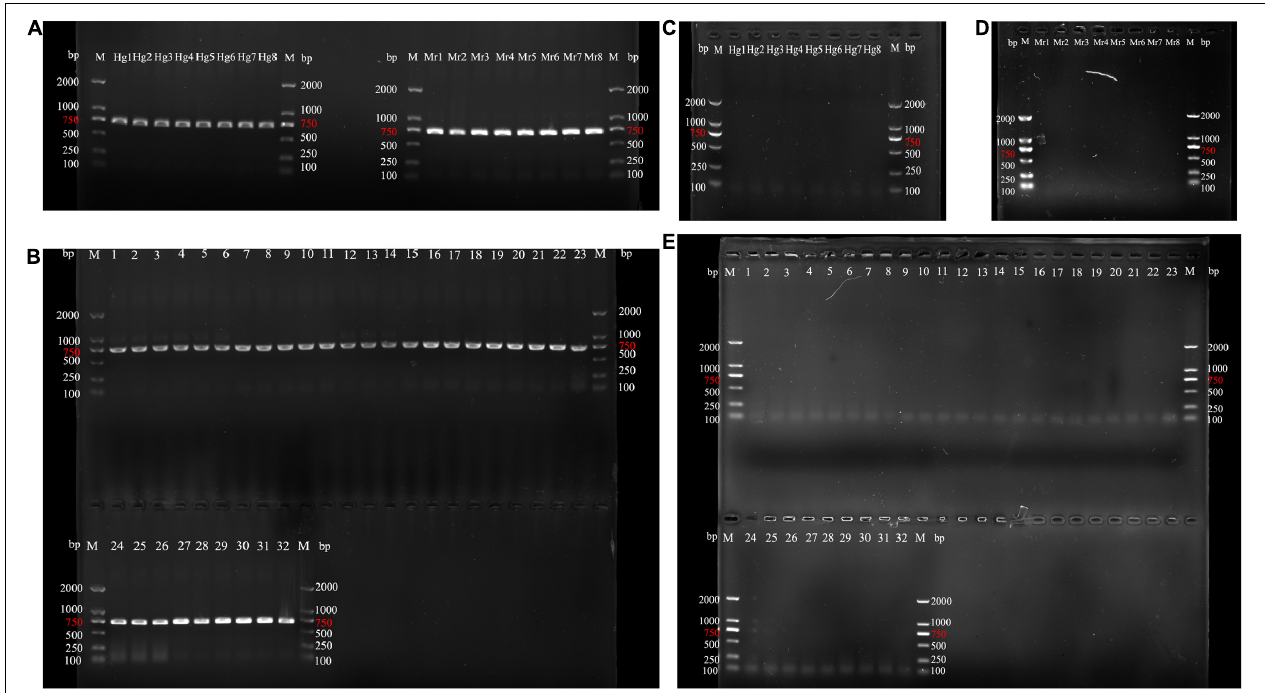
FIGURE 1 | PCR product agarose gel results for amplifying COI sequences using optimal conditions. (A,B) Agarose gel electrophoresis of unprocessed samples. (C–E) Agarose gel electrophoresis of processed samples. Genuine samples: Hg1-Hg8; Mr1-Mr8: M. reevesii samples; 1–4: C. serpentina ; 5–6: C. galbinifrons ; 7–8: